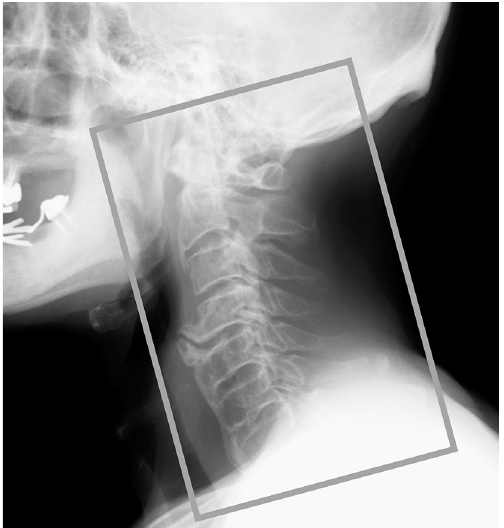
Figure 2. Image preprocessing for the convolutional neural network model training and validation. We cropped the smallest region with an aspect ratio of 2:3 (white box) containing vertebral bodies and spinous processes of C1–C7 in lateral cervical spine